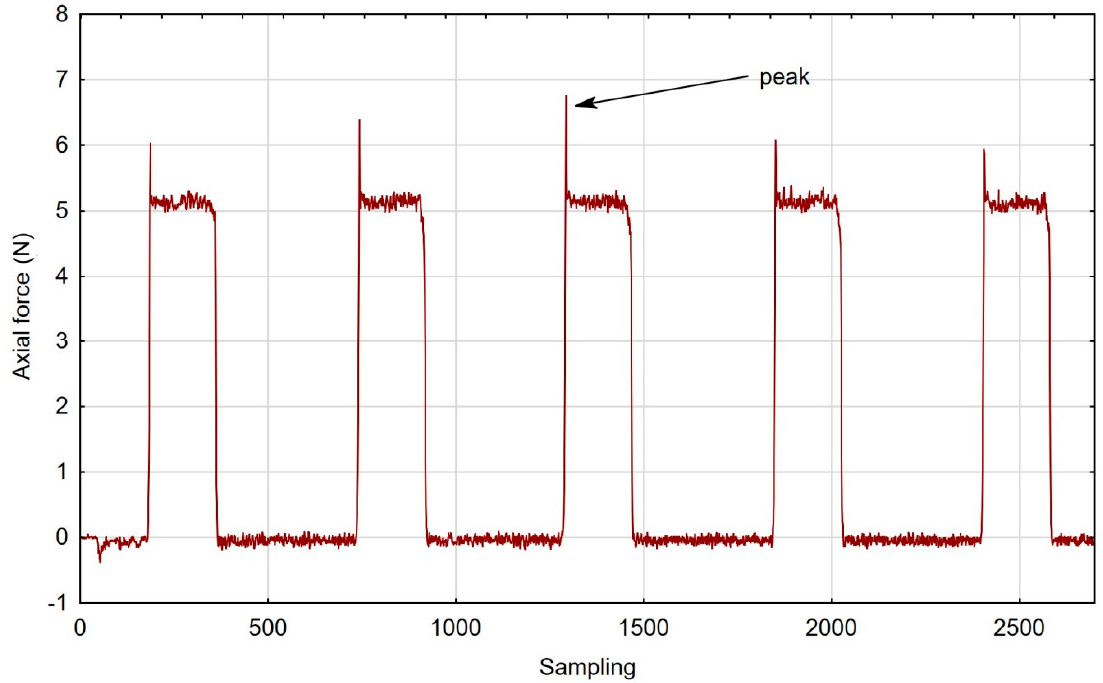
Figure 7. Axial force during brush treatment with the white fibre tool and “low” spring in the offset adjustment sleeve.